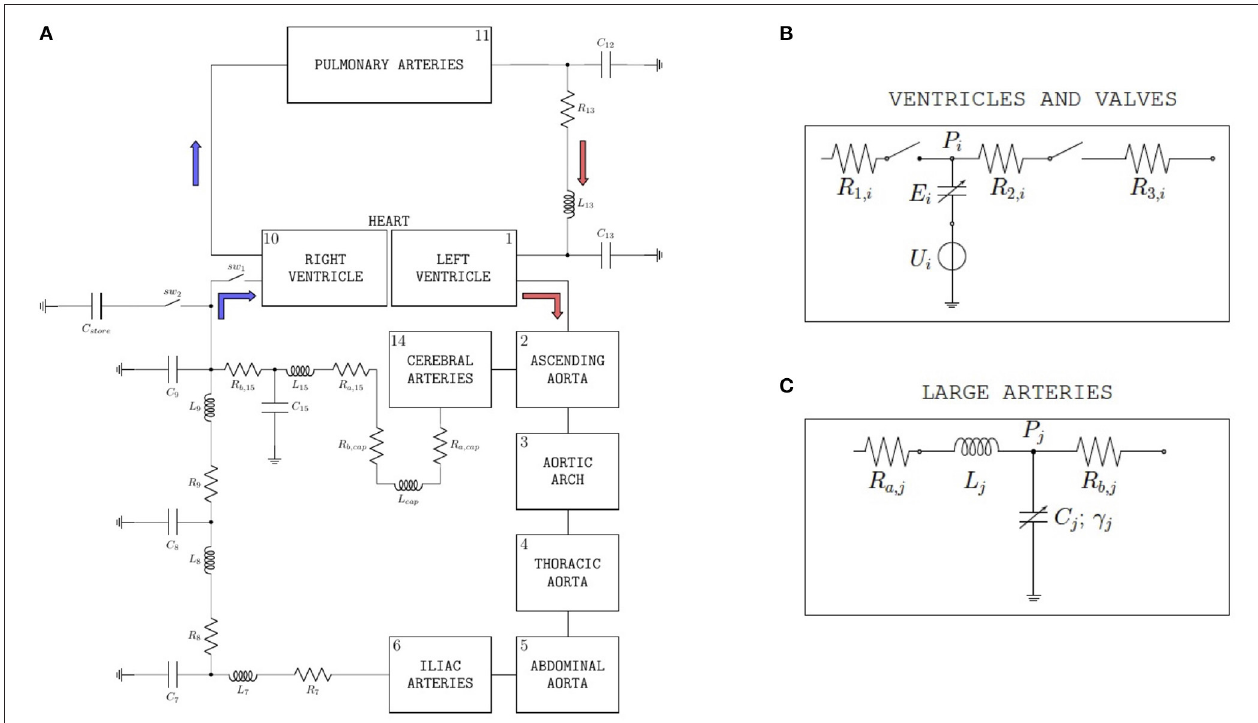
FIGURE 1 | (A) Schematic representation of the closed-loop model utilized to simulate blood flow through the cardiovascular system. With respect to the version of the model described in ( 29), two ideal switches ( sw 1 and sw 2 ) and a capacitor ( C store ) have been added upstream of the right ventricle in order to simulate the experimental procedure performed on swine to acquire data of left-ventricular pressure and volume. (B) Basic model components for ventricles and valves. The subscript i is used to distinguish between left ( i = L ) and right ( i = R ) ventricles; P i is the ventricular pressure; R 1, i , R 2, i , and R 3, i are hydraulic resistances assumed to be constant; U i and E i characterize ventricular pumping, E i representing the variable ventricular elastance. (Bottom) Large arteries; the subscript j is used to distinguish among different arterial segments, specifically aortic arch ( j = 3), thoracic aorta ( j = 4), abdominal aorta ( j = 5), and iliac arteries ( j = 6); P j is the pressure of the specific arterial segment; R a , j and R b , j are the hydraulic resistances; L j is the inductance; C j and γ j represent elastic and viscoleastic properties of the arterial wall, respectively. (C) Basic model components for large arteries. The subscript j is used to distinguish among different arterial segments, specifically aortic arch ( j = 3), thoracic aorta ( j = 4), abdominal aorta ( j = 5), and iliac arteries ( j = 6); P j is the pressure of the specific arterial segment; R a , j and R b , j are the hydraulic resistances; L j is the inductance; C j and γ j represent elastic and viscoleastic properties of the arterial wall,